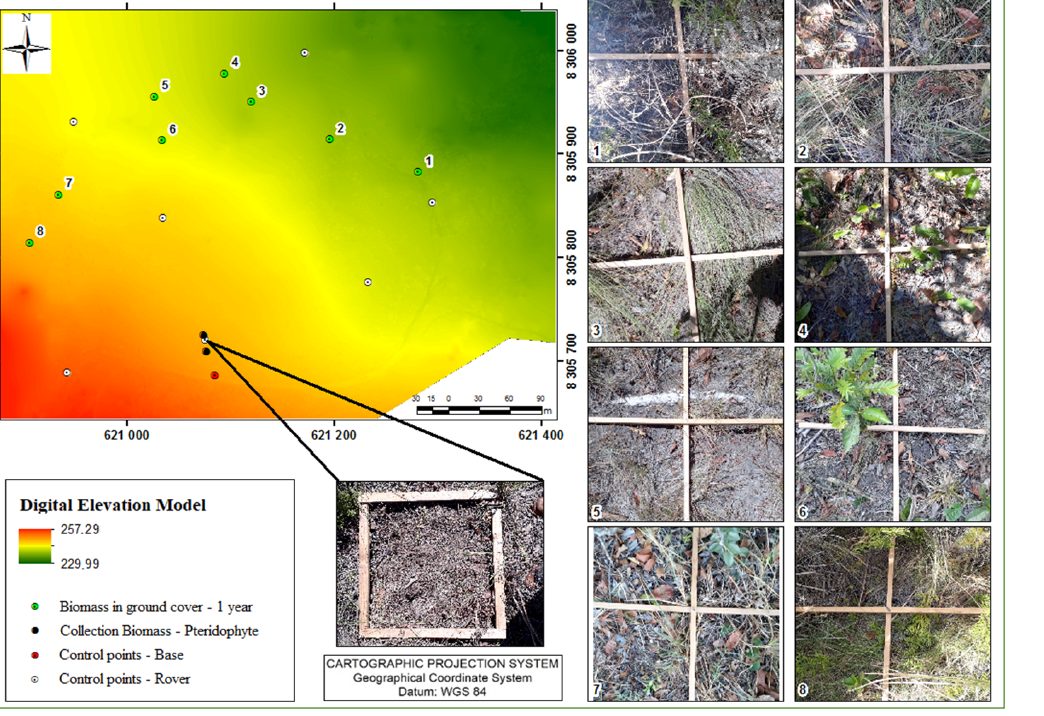
Table 1. Features selected by the optimization function on each classification obtained.